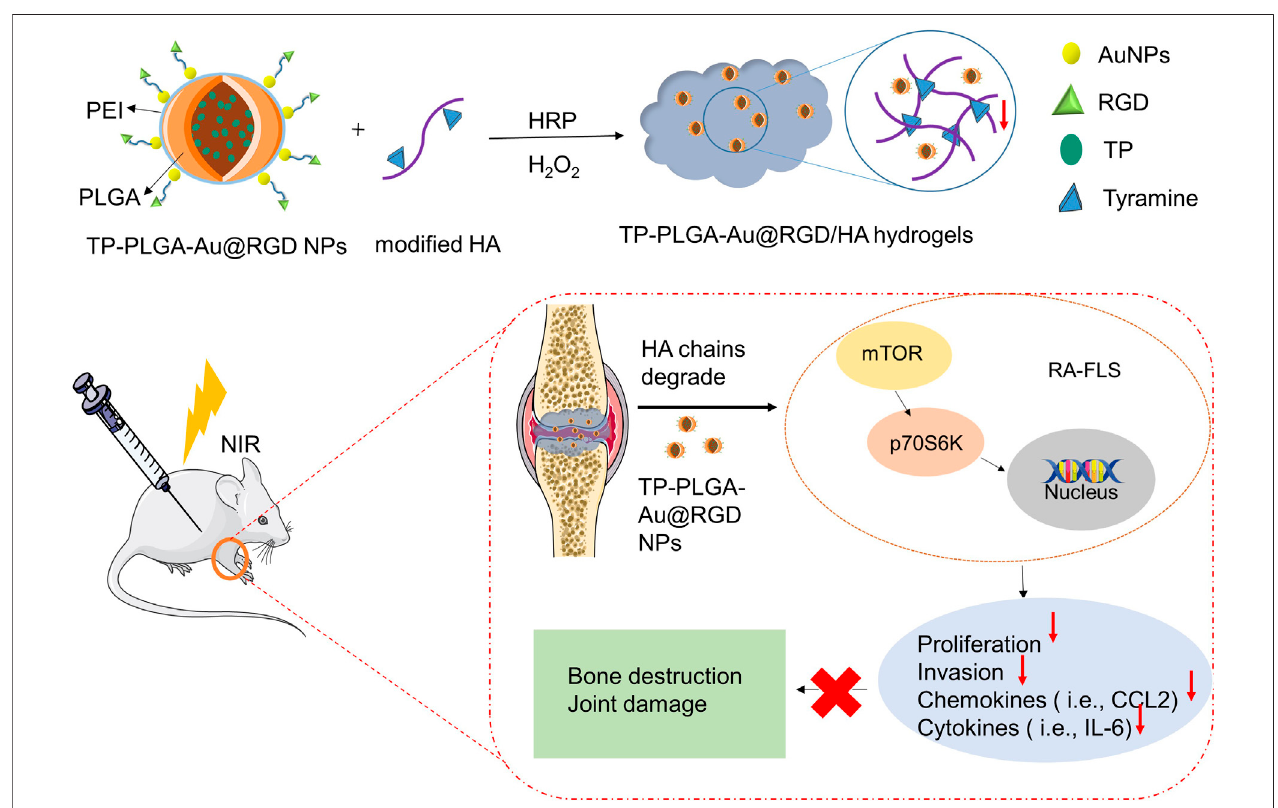
FIGURE 1 | Preparation process of TP-PLGA-Au@RGD/HA hydrogels and schematic illustration of the anti-in fl ammatory effect of TP-PLGA-Au@RGD/HA hydrogels in CIA mice.